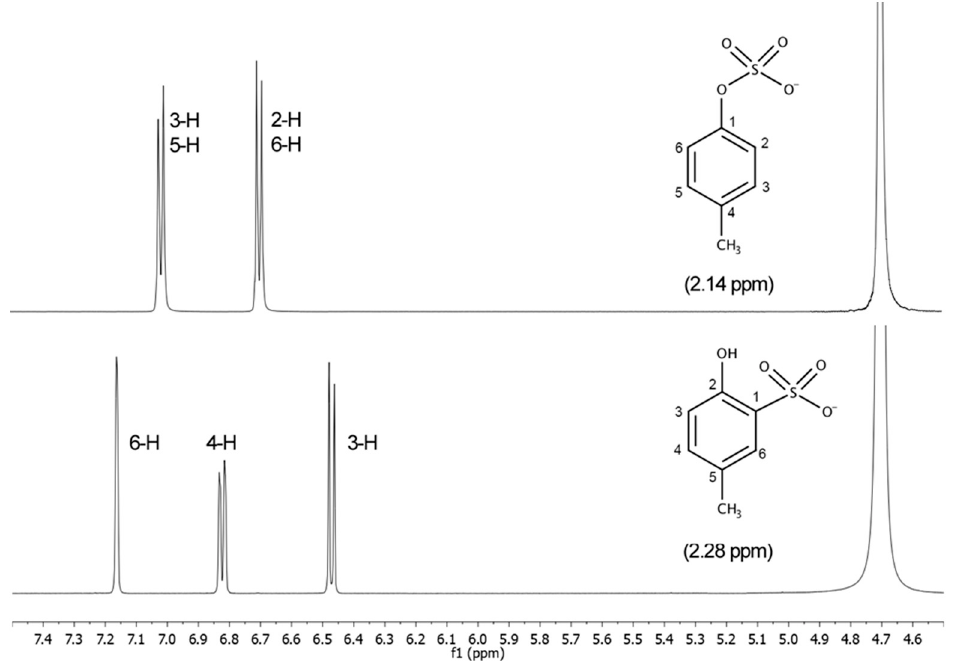
Figure 3. 1 H-NMR spectra of p CS ( 1 , top ) and 2-hydroxy-5-methylbenzenesulfonic acid ( 2 , bottom ).